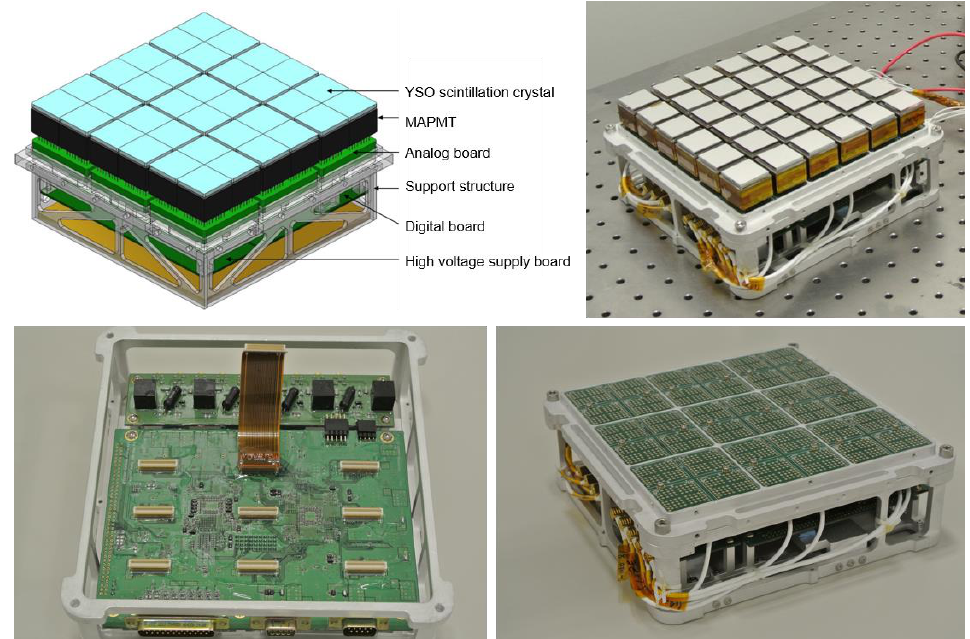
Figure 2. UBAT detector. A rendering of an integrated UBAT detector (top left) and the integrated flight model of a UBAT detector (top right). Bottom part of a UBAT detector. A high-voltage board and a digital board are assembled in the detector structure. One FPCB is connected to the digital board (bottom left). Integrated UBAT detector top and bottom part. The nine analog boards are connected to the digital board and the high-voltage supply board, respectively (bottom right).